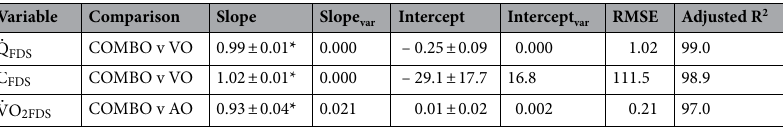
˙ VO 2 : muscle O 2 uptake. Var: